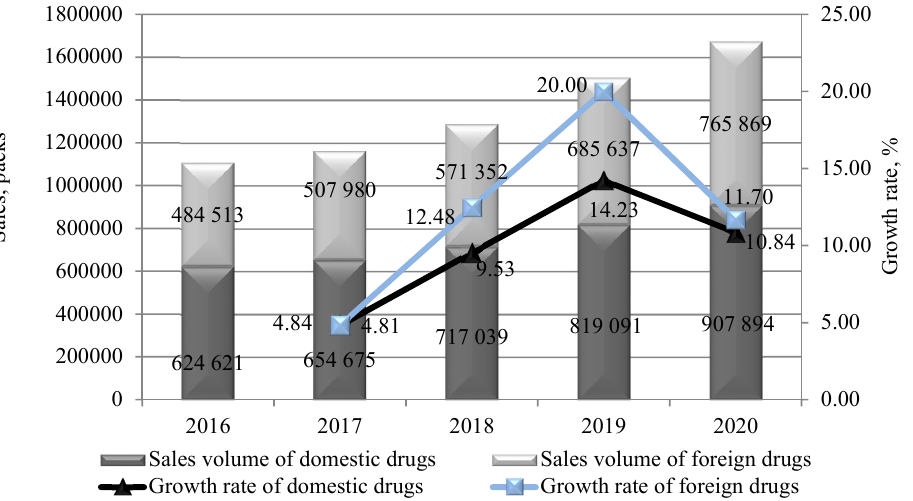
Fig. 5. Dynamics of indicators of retail sales of antiepileptics in physical terms for the pharmaceutical market of